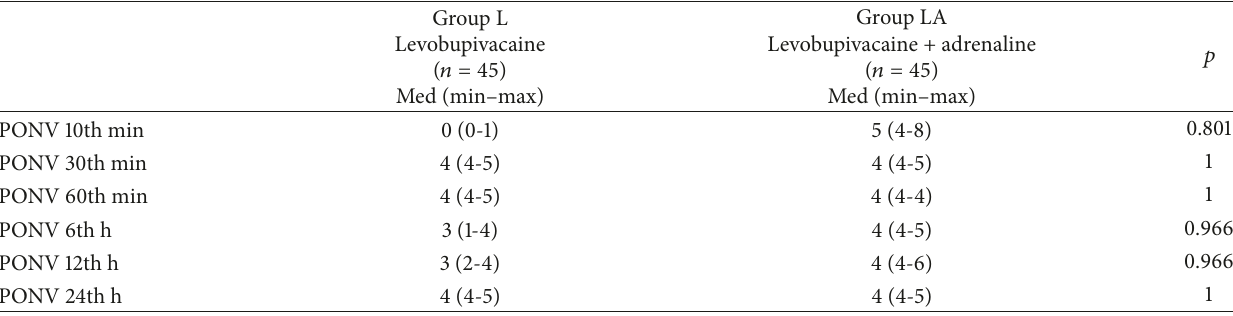
Table 4: The PONV variables of two groups at each time interval after operation and values given are median (min–max). Group